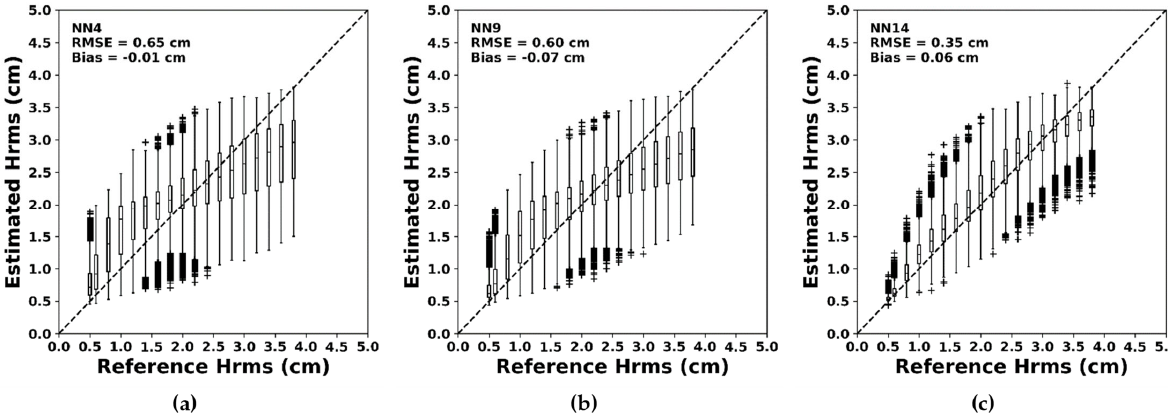
Figure 6. Estimated Hrms as a function of the reference Hrms using simulated L ‐ band data: ( a ) NN without a priori information on SSM; ( b ) NN with a priori information on SSM in dry to slightly wet soil conditions; ( c ) NN with a priori information on SSM in very wet soil conditions. The non ‐ filled boxes represent the distribution of the estimation results at each class with the median line of the scores, and the plus signs represent the outliers of the estimations located outside the whiskers of the box plot.